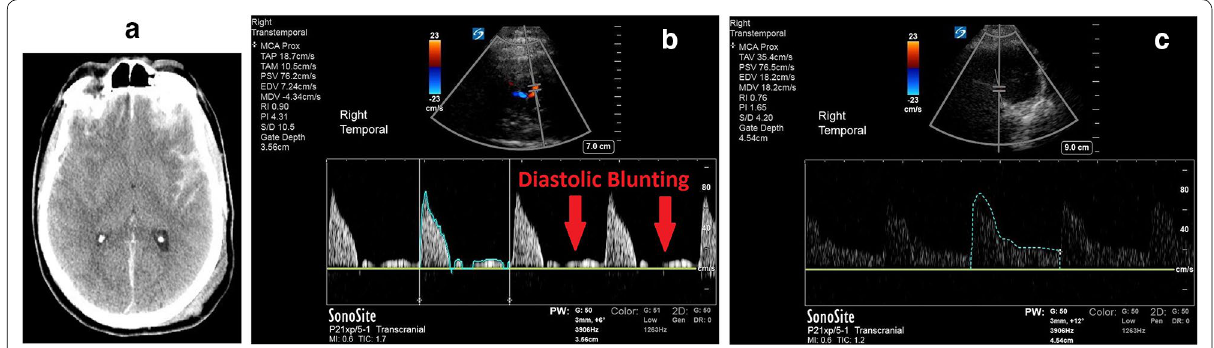
Fig. 3 Raised intra-cranial pressure by spectral Doppler on TCD, as calculated by pulsatility index. a Diffuse subarachnoid hemorrhage on CT head. b Spectral Doppler of MCA, demonstrating diastolic blunting secondary to raised ICP (pulsatility index ventions to reduce ICP, there was normalization of diastolic flow in the MCA, and resolution of high ICP (pulsatility index